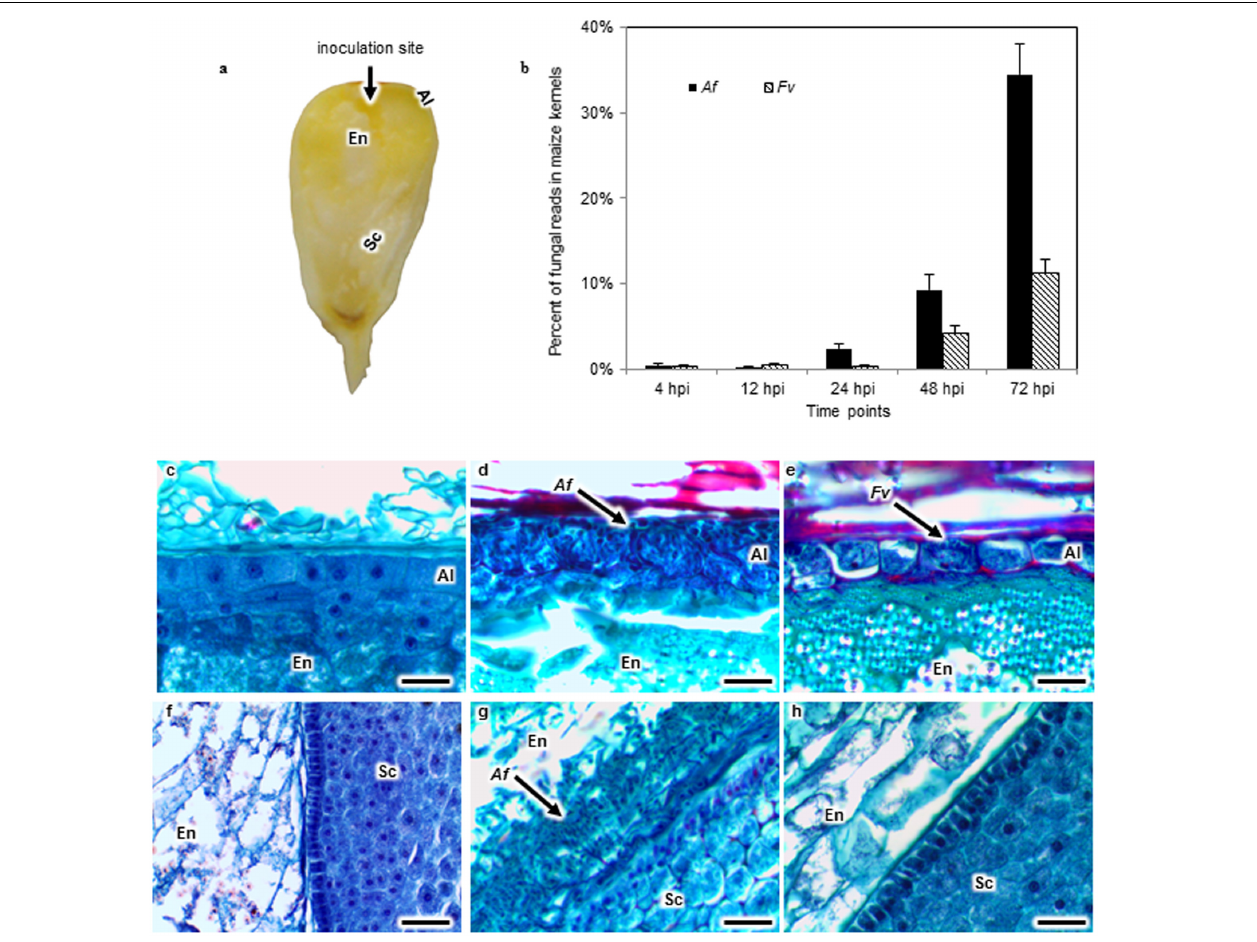
FIGURE 1 | Aspergillus flavus (Af) and Fusarium verticillioides (Fv) colonization of maize kernels developing in the field. Kernels in early dough stage (20–22 days after pollination) were inoculated by inserting a pin dipped into either an Af or Fv conidial suspension into the crown of exposed kernels, introducing approximately 13 spores into the endosperm (En) tissue (a) . The percent of fungal RNA-seq reads in the total reads of Af or Fv infected kernels at 4, 12, 24, 48, and 72 h post inoculation (hpi) indicated that fungal tissues increased over time in the kernel, and A. flavus more extensively colonized the kernel than F. verticillioides at 24, 48, and 72 hpi (b) . Kernel sections collected at 72 hpi were stained with safranin and fast green (c–h) . No fungal colonization was observed in the aleurone (Al), En or scutellum (Sc) of a mock inoculated kernel (c,f) . Af colonized and destroyed the Al (d) , whereas Fv colonized around the intact Al (e) . Af colonized the EnSc interface forming a biofilm-like structure (g) . But the biofilm like structure was not observed in Fv inoculated kernels (h) . Arrows denote fungal colonization. Scale bars: 30 µ